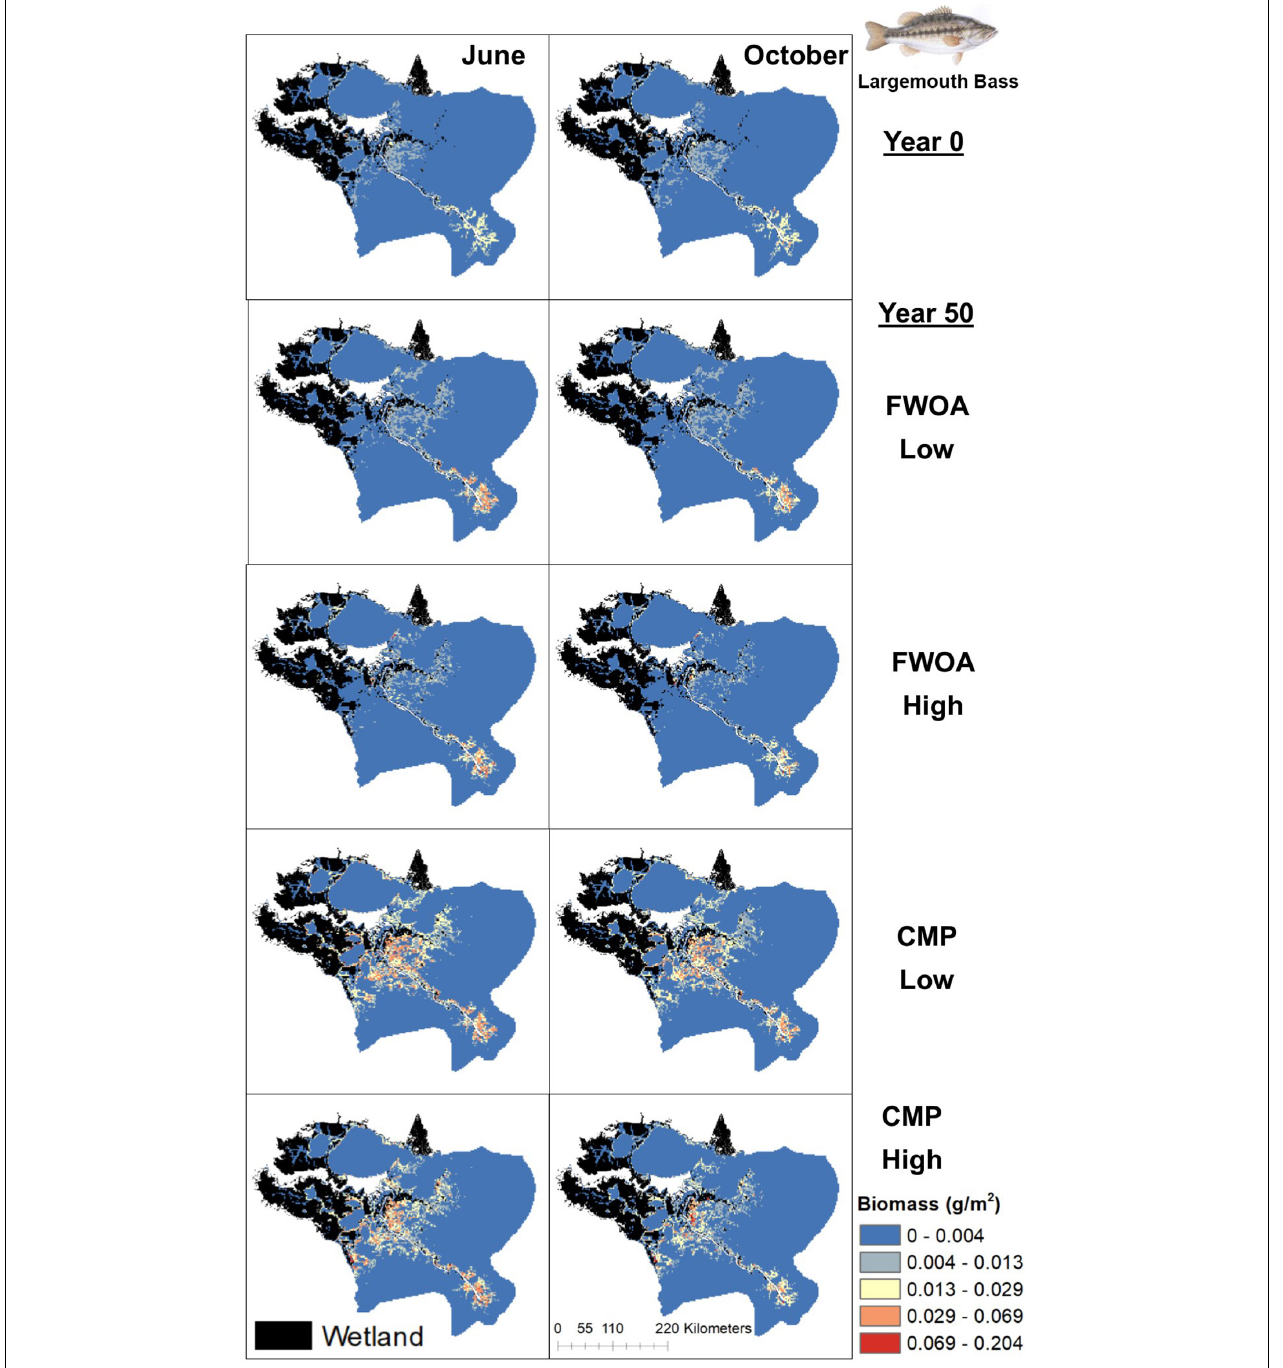
FIGURE 10 | Spatial distribution of juvenile Largemouth Bass in different simulations. Output is shown from June and October in Year 0 and Year 50, under “Low” and “High” relative sea level rise (see Supplementary Table S6 for scenarios), and with Coastal Master Plan (CMP) implementation and without (FWOA).